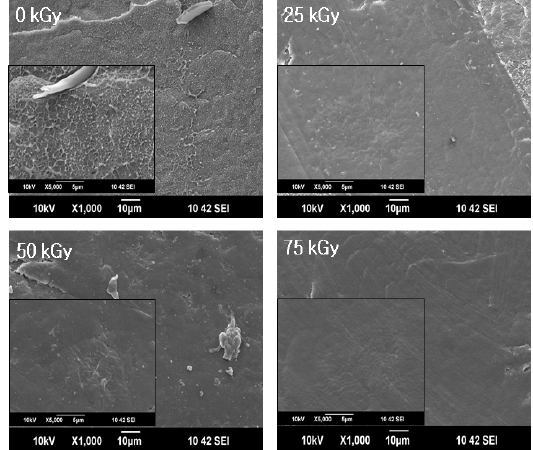
Figure 4. Scanning electron microscope (SEM) micrographs of PU (3 phr)/HDPE composites at various absorption doses.